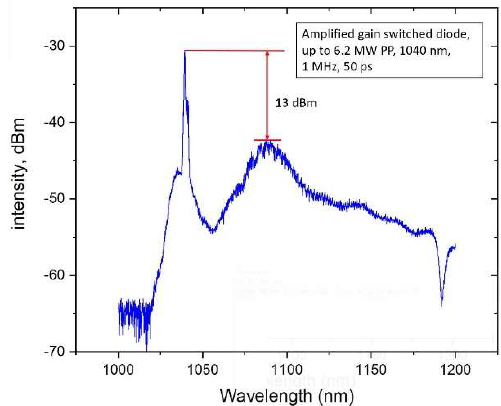
Fig.5. Output spectra of high power MOPA system at 1 MHz repetition at the maximum achieved output power.